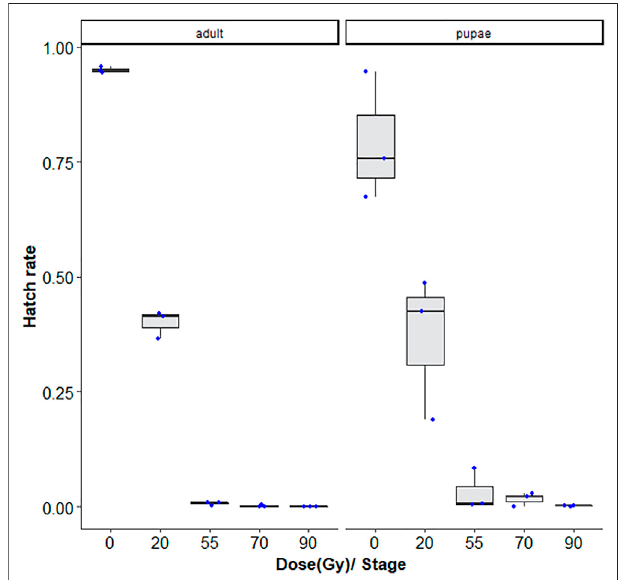
FIGURE 2 | Dose-response shown as egg hatch rate of Aedes aegypti pupae vs. adults. The boxplot shows the median, and upper and lower quartiles. The dots indicate the values obtained for each